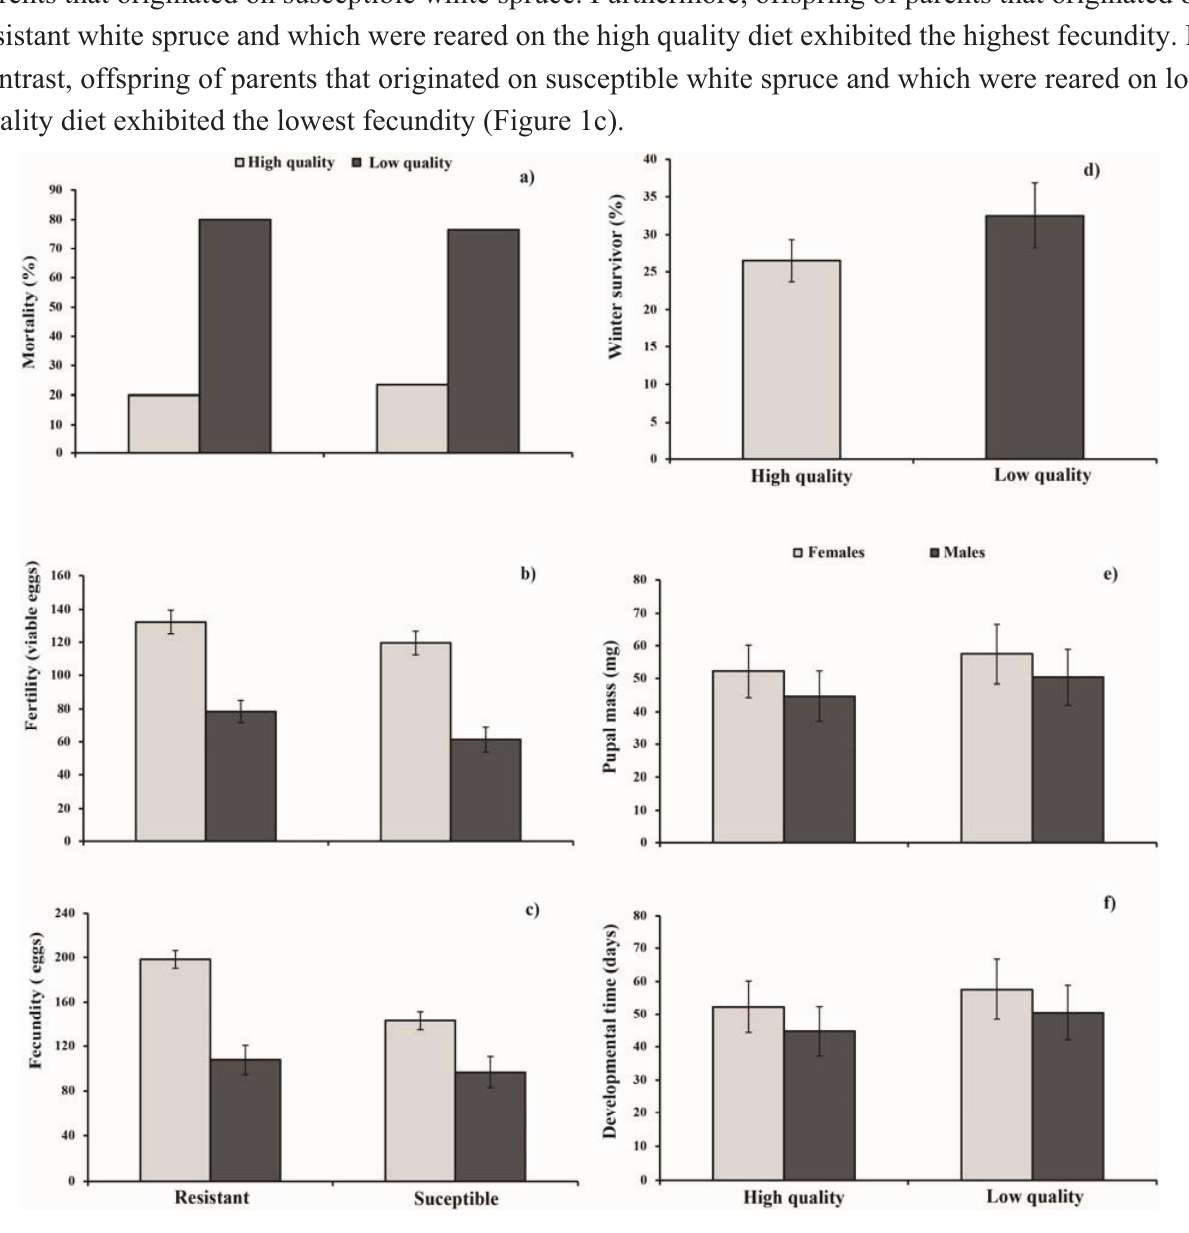
Figure 1. Spruce budworm offspring performance summarized by tree phenotype ( a – c ) and diet quality ( d – f ) (LSMEANS ±